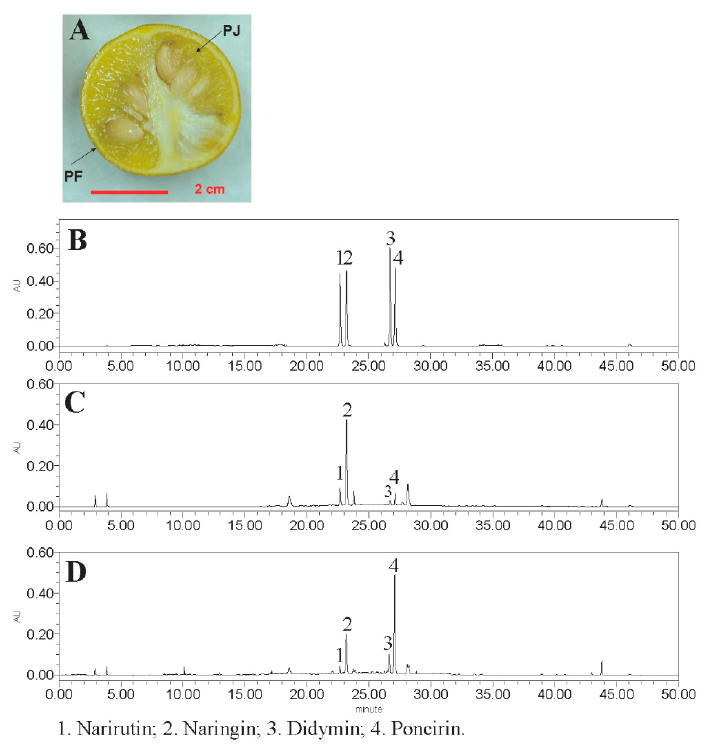
Figure 1. P. trifoliata fruit ( A ) and HPLC chromatograms of four flavanone standards ( B ); P. trifoliata flavedo (PF) ( C ); and juice sacs (PJ) ( D ) extracts ( λ = 280 nm).